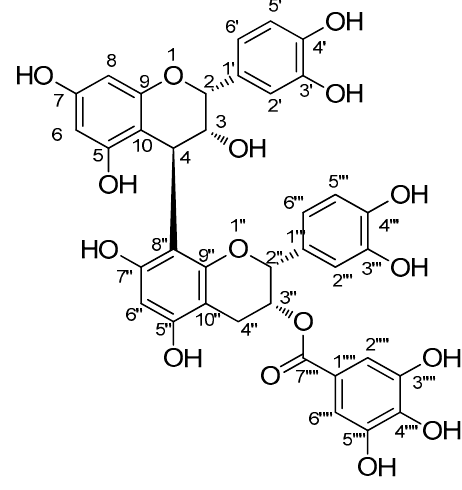
Figure 2. The chemical structure of 1 .